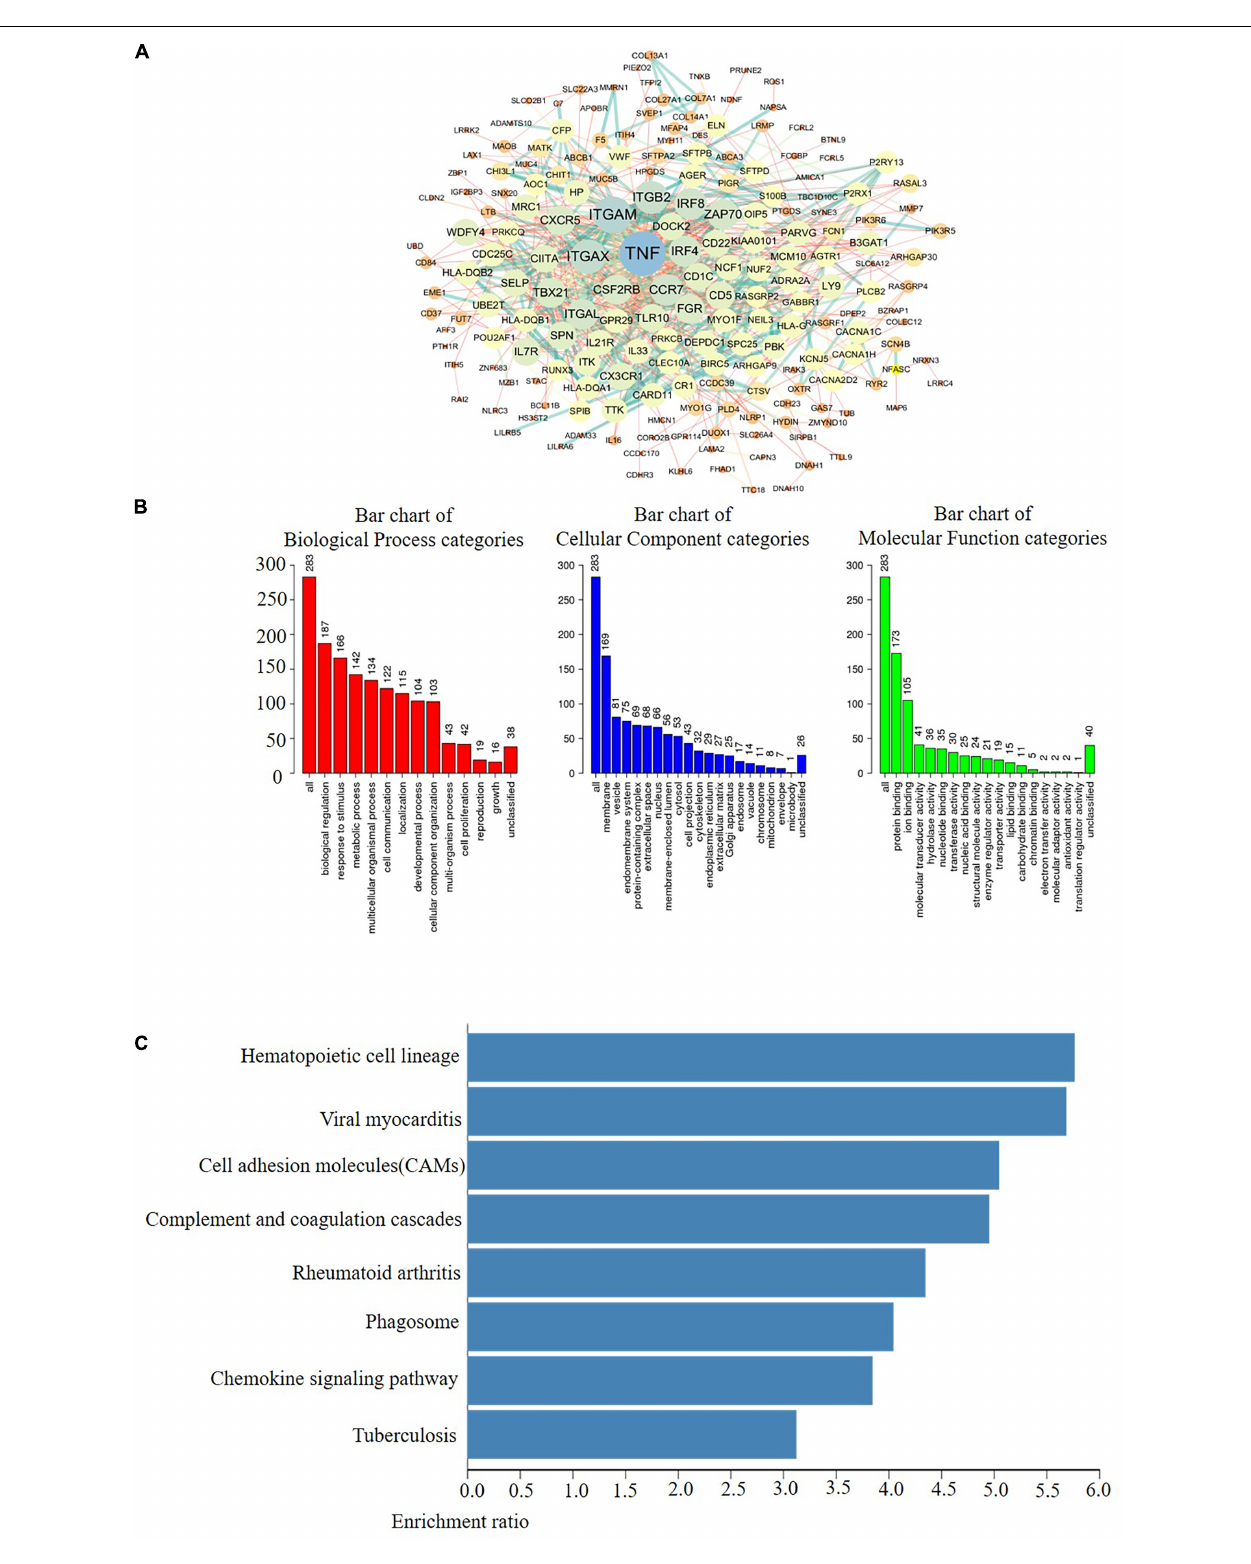
FIGURE 5 | Coexpression network analysis of the AlkB family in LUAD. (A) The PPI network of AlkB family interaction partners generated by the frequently used c-BioPortal and Cytoscape. (B) Primary molecular functions, biological processes and cell components related to the biology of the AlkB family were identified using WebGestalt. (C) Bar plot of KEGG enriched terms analyzed by WebGestalt.